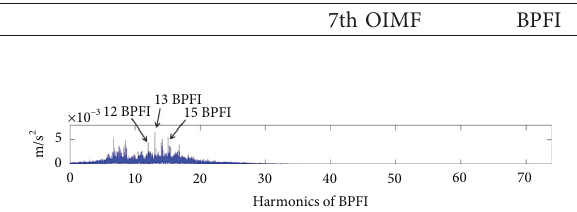
Figure 5: Defect on the inner race: channel 1, 2nd OIMF, referred to the BPFI.